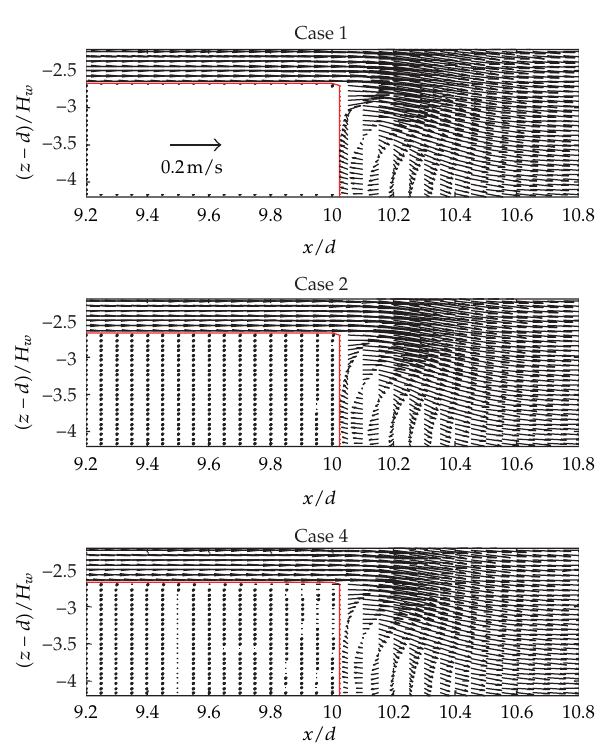
Figure 7: Velocity field at t (cid:2) g/d (cid:3) 0 . 5 (cid:7) 59 . 5 as a solitary wave passes over a submerged impervious (cid:2) Case 1 (cid:3) and two di ff erent permeable breakwaters (cid:2) Cases 2 and 4 (cid:3)